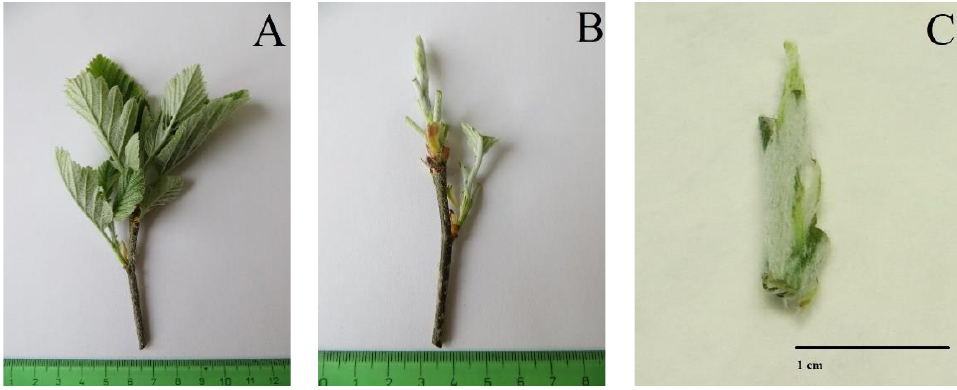
Figure 7. Explant source in Sorbus sp. ( A ) Original shoot. ( B ) Prepared shoot before explant disinfestation. ( C ) Initiation explant.